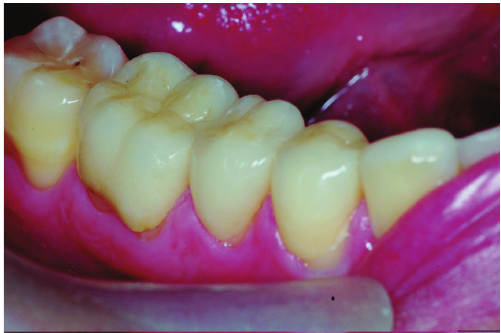
Figure 15: The posterior quadrant view of mandibular teeth with periodontal tissues free of gingival inflammation and no visible deteriorations of the